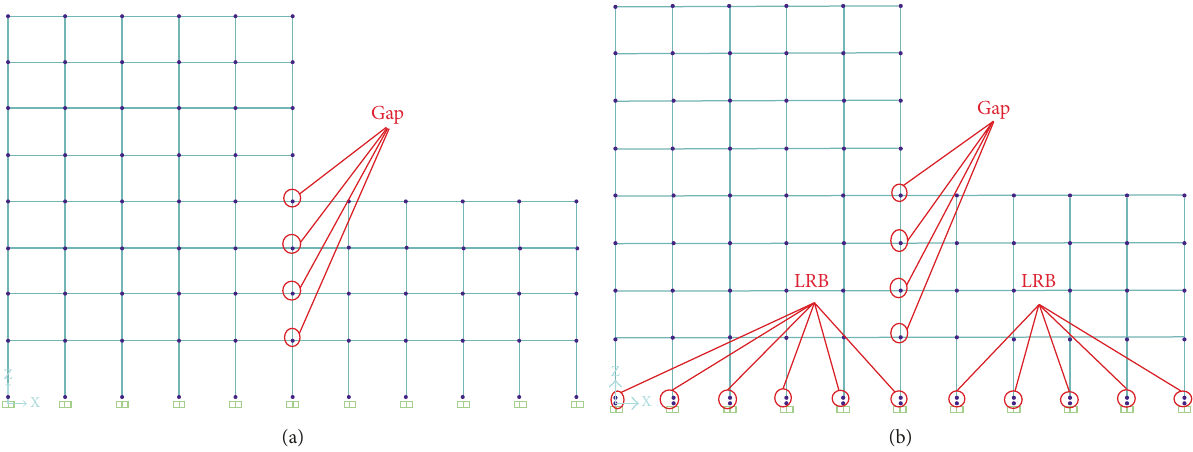
Figure 5: Location of gap elements and LRB devices in FFB and FBI buildings. (a) FFB adjacent buildings. (b) FBI adjacent buildings. Table 1: Structural members of OMRCF adjacent buildings. Column section